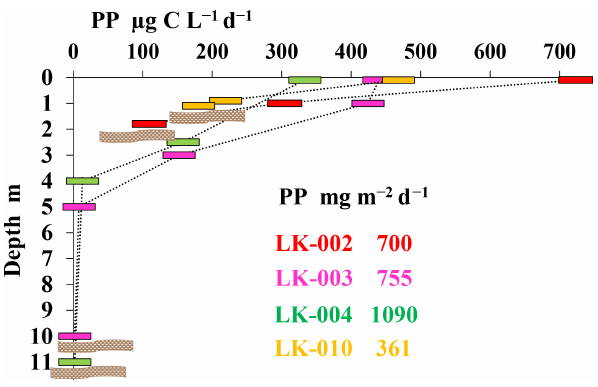
Figure 2. Primary production (PP) in four lakes of the Yamal Peninsula (August 2019) in the water horizons (µgCL − 1 d − 1 ) and integral PP for the entire water column (mgCm − 2 d − 1 ). For all stations, location of the bottom is indicated by a brown wavy